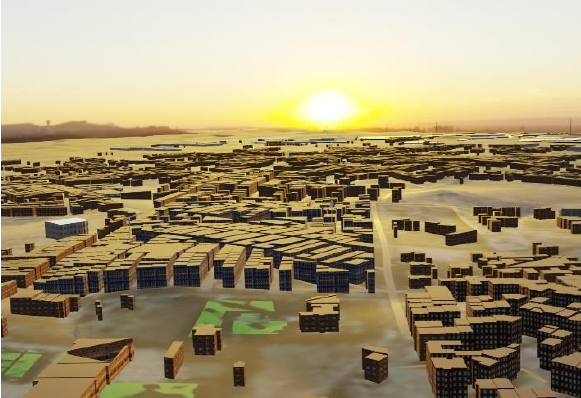
Figure 13 . Biougra city 3d model captured from Blender